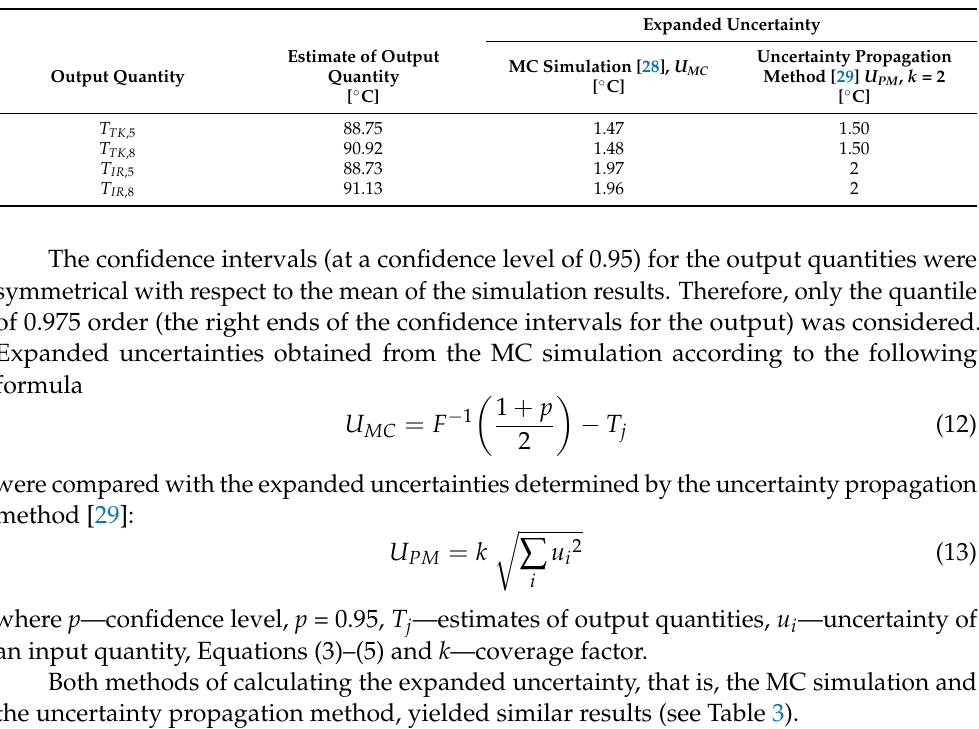
Table 3. Estimates of output quantities and expanded uncertainties of temperature